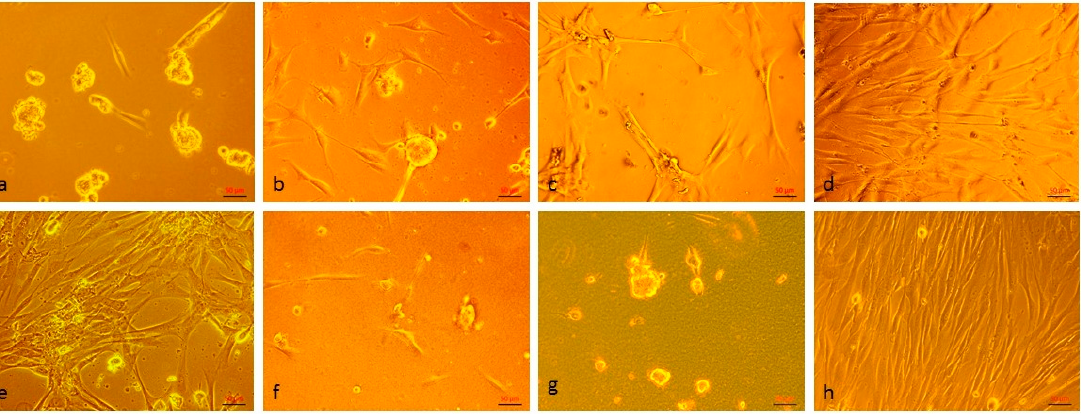
Figure 7. Human dermal fibroblasts were cultured on ( a ) CS, ( b ) CS+0.5%CN, ( c ) CS+1%CN, ( d ) CS+5%CN, ( e ) CS+10%CN, ( f ) CS+20%CN, ( g ) CS+30%CN film matrices, and ( h ) cultural polystyrene surface (control) for 4 days. Original magnification 200X, phase-contrast light microscopy, scale bar represents 50 μ m.